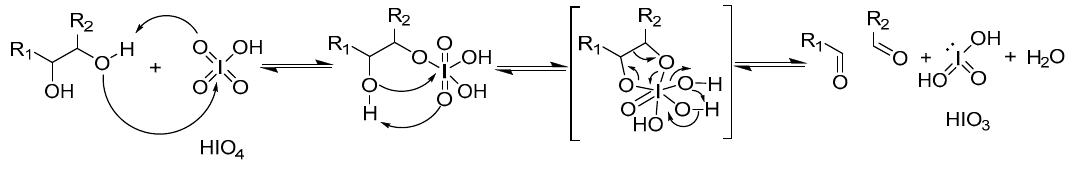
Figure 3. Malaprade oxidation of glycols.